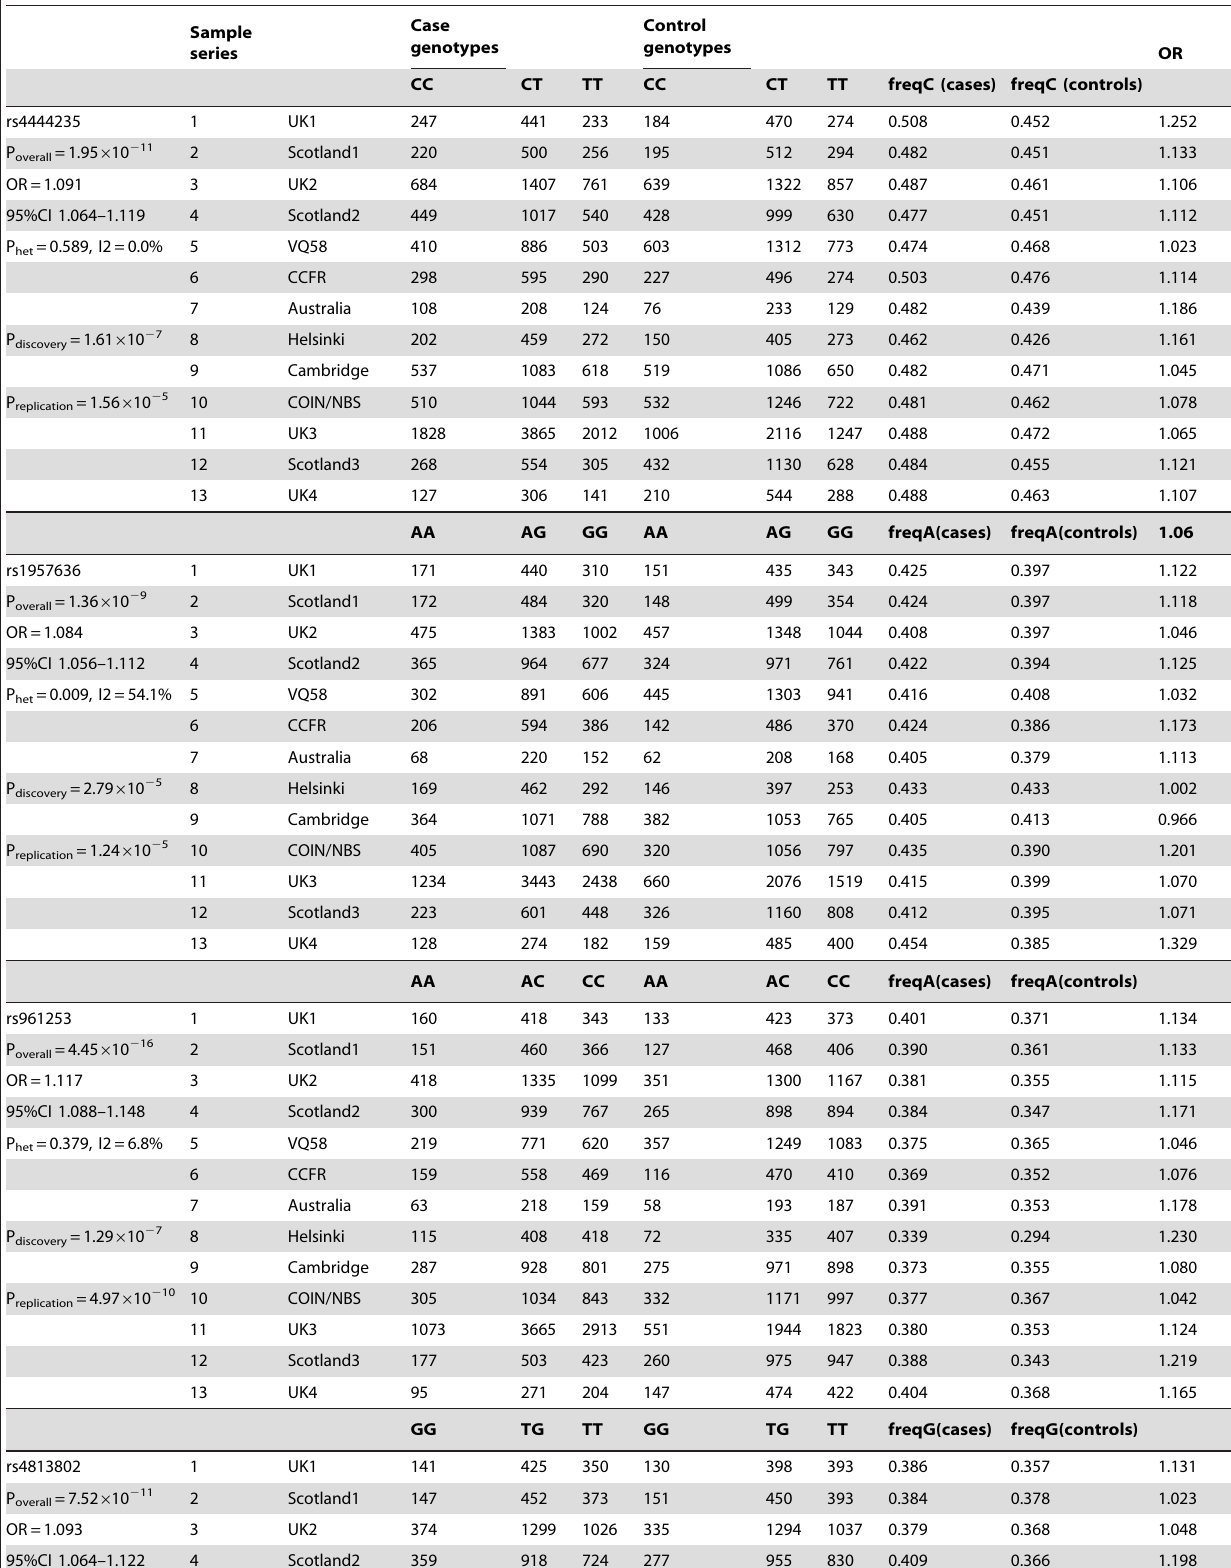
Table 2. Summary of individual SNP association analysis for rs4444235, rs1957636, rs961253, and